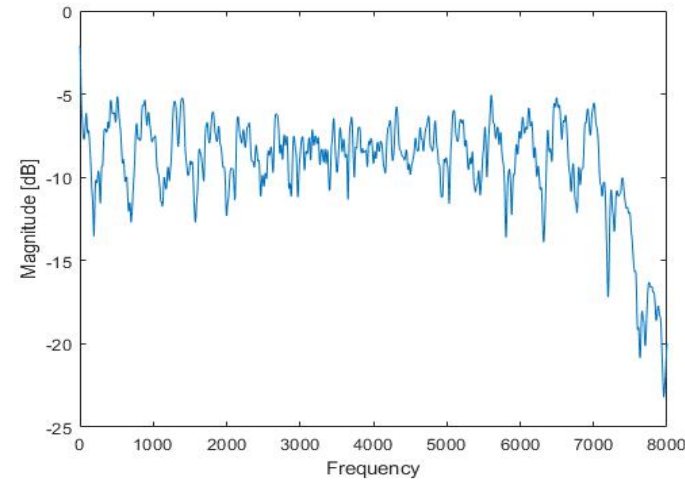
Figure 5. The room transfer function of the experiments.